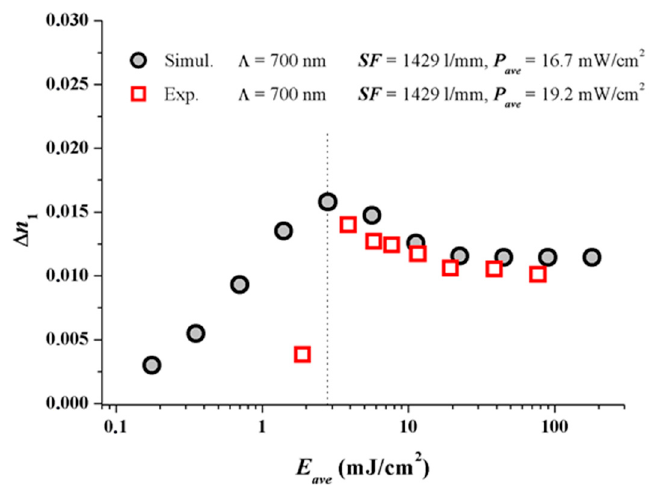
Figure 3. Comparison of dosage response curves for simulated data and experimental data for similar recording power densities P ave [17]. Note for the same P ave simulation and experiment should coincide.